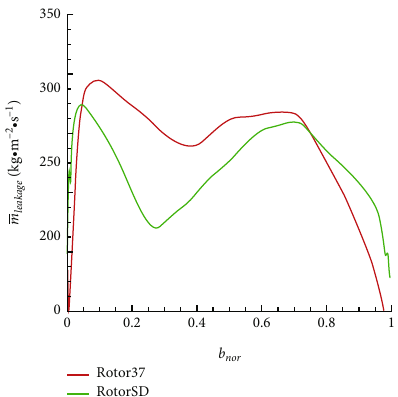
Figure 23: Distributions of the average leakage fl ow rate at a tip clearance of